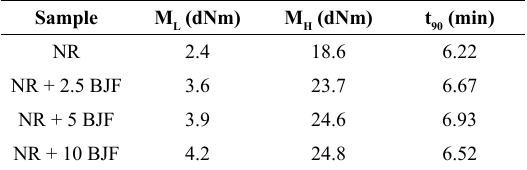
Table 2. Vulcanizing behavior of the compounds at